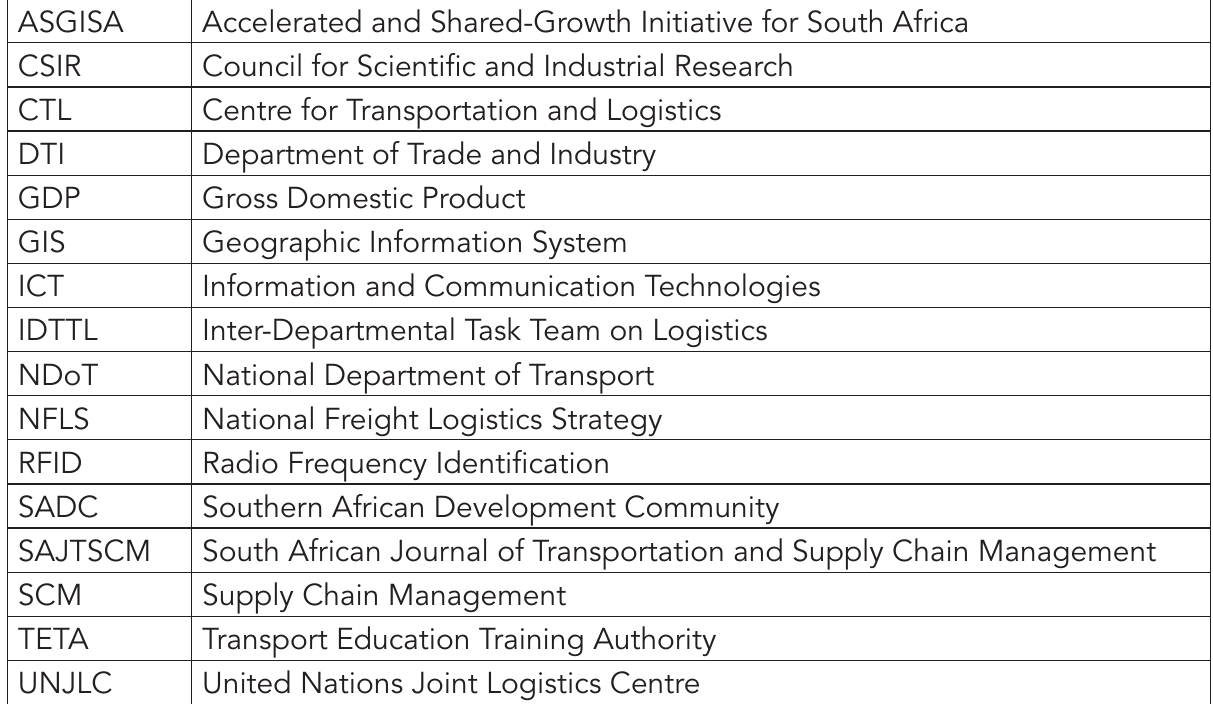
Table 1: Acronyms